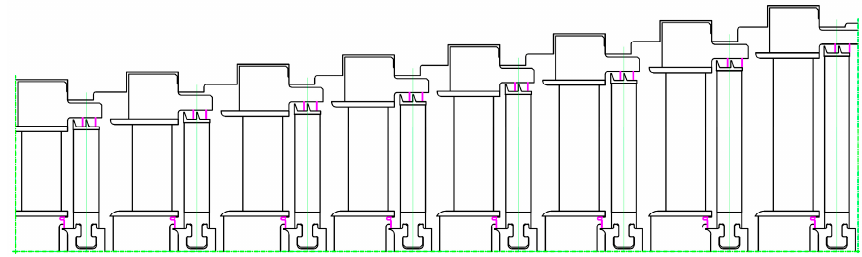
Figure 14. Turbine flow part for Variant 6 and MM working fluid.